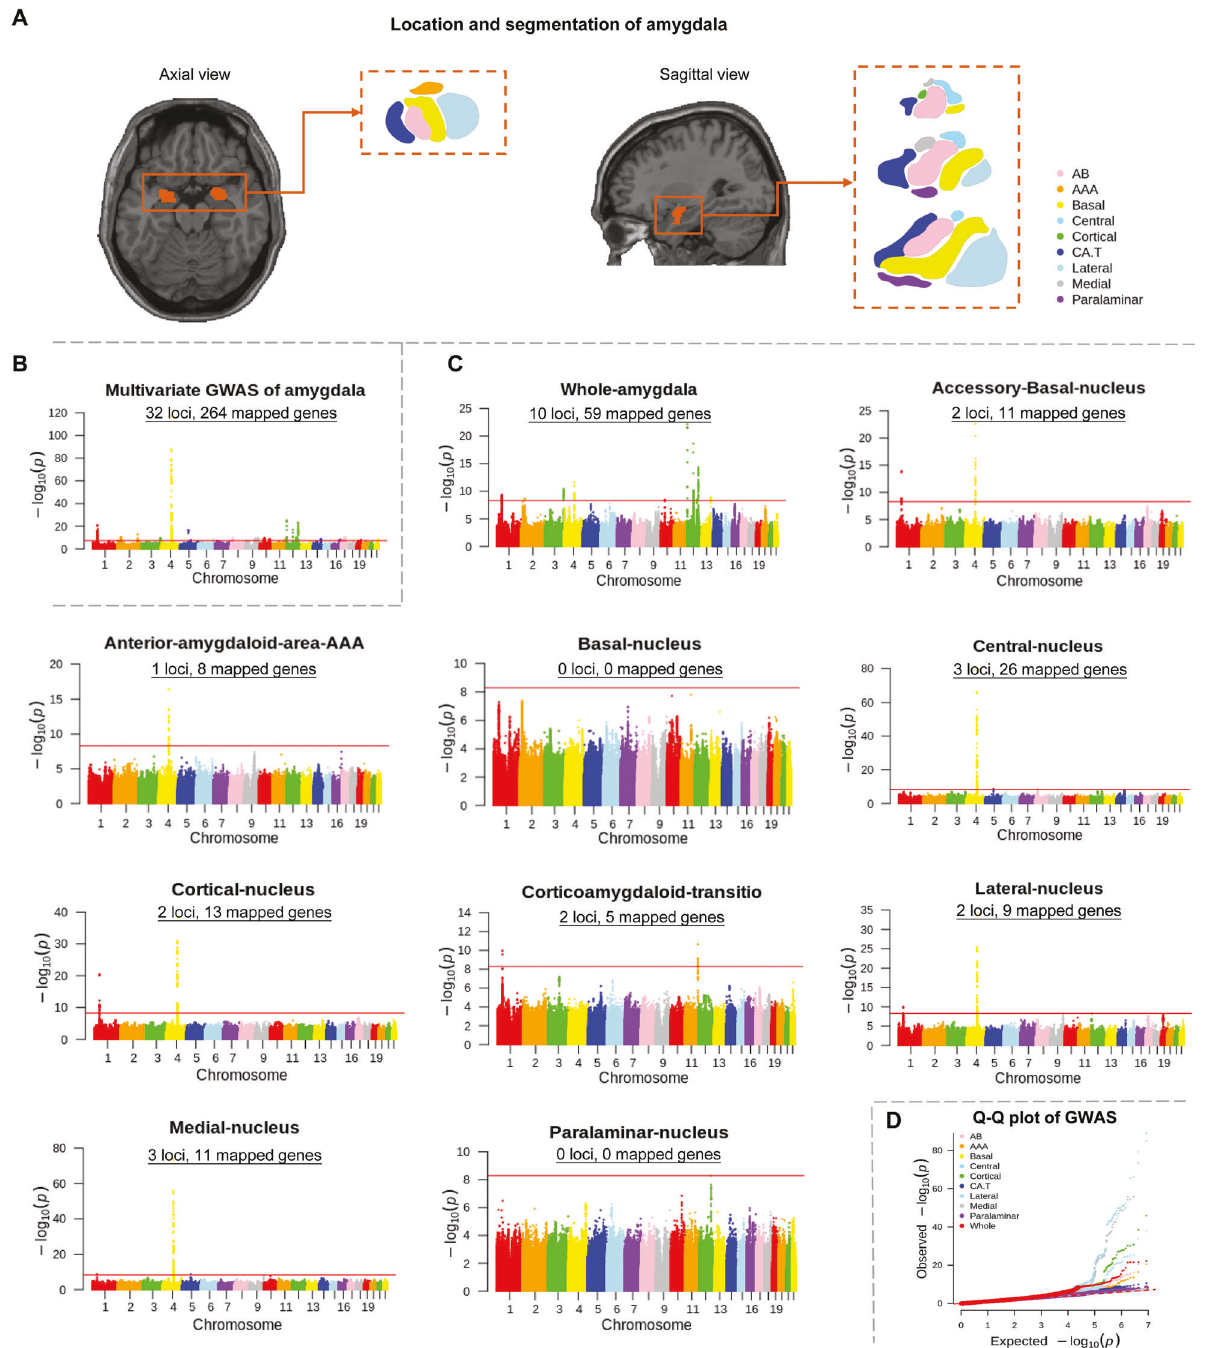
Fig. 2 Multivariate and univariate GWAS of amygdala volumes. A The location of the amygdala region in the human brain (colored in orange) and the subdivisions of the amygdala from the sagittal and axial view. B Multivariate GWAS for amygdala volumes. This part illustrates the -log10( P ) statistic from the multivariate GWAS across the entire formation, with 32 signi fi cant loci. The GWAS signi fi cant threshold is set at P < 5 × 10 − 08 . C Manhattan plots of genetic variants underlying univariate GWAS of amygdala volumes. Number of signi fi cant genetic loci and mapped genes are listed in Manhattan subplot titles, with the horizontal red line denoting GWA signi fi cance ( P < 5 × 10 − 09 ). D Q-Q plot of the GWAS for the amygdala volumes. The Q-Q plot showed that potential population strati fi cation and/or cryptic relatedness are well controlled after genomic correction. GWAS genome-wide association study, Q-Q quantile-quantile, AB accessory-basal nucleus, AAA anterior- amygdaloid-area, CAT corticoamygdaloid